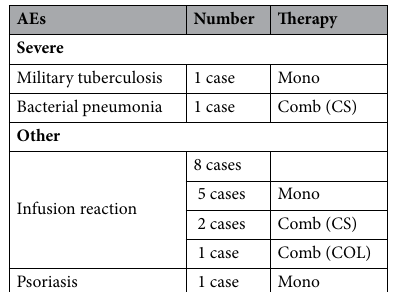
Table 4. Details of AEs. Mono: monotherapy, Comb: combination therapy, AEs: adverse events, IFX: infliximab, CS: corticosteroid, COL: colchicine.